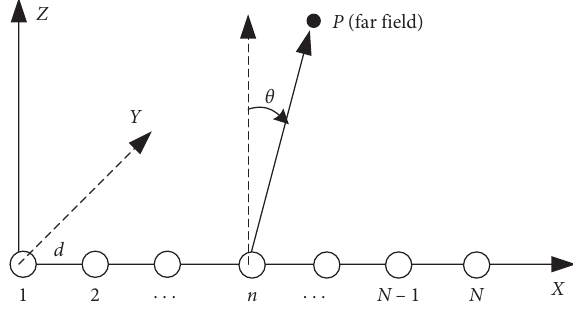
Figure 7: Schematic diagram of linear array